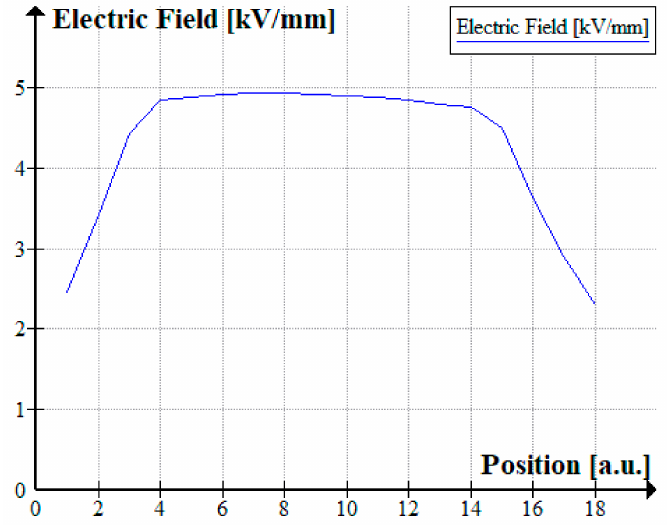
Figure 6. Electric field intensity on the surface of the emitter ring over the linear position along the emitter-ring